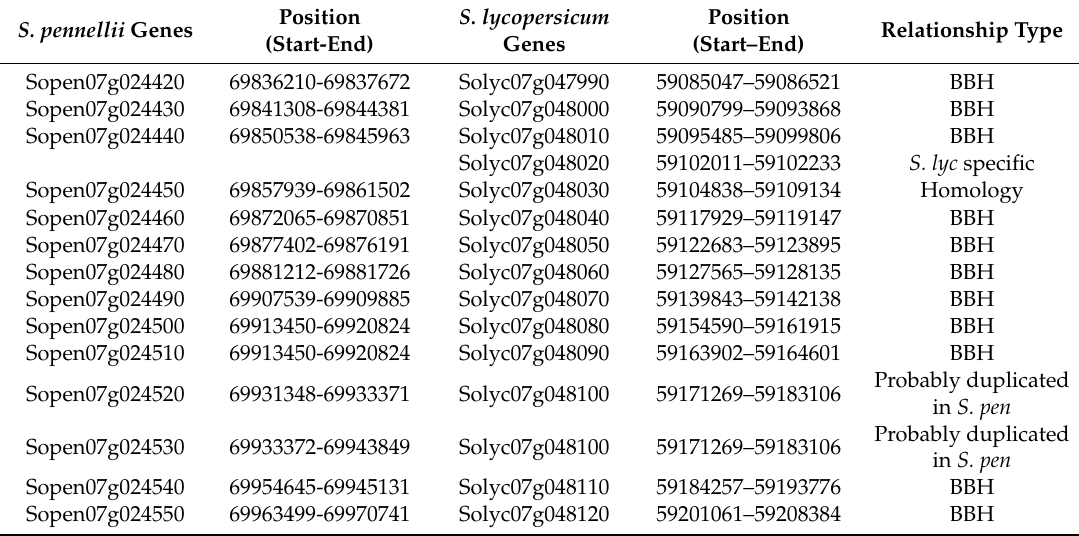
Figure 2. Reconstruction of the introgressed wild region in R182 by the synteny analysis of the genomic portion of chromosome 7 between S. pennellii and S. lycopersicum . The introgressed genes of S. pennellii , the replaced genes of S. lycopersicum, and their function annotation were highlighted in the right side of the figure. Genes evidenced in red represent species-specific genes. Experimentally tested markers ( + ) and duplicated genes (*) were reported next to the corresponding genes. Table 3. Homologous relationships between genes of S. pennellii ( S. pen ) (release v2) and S. lycopersicum M82 ( S. lyc ) (release iTAG 4.1) belonging to the introgressed region of R182 sub-line. For each gene, the position and the relationship type were